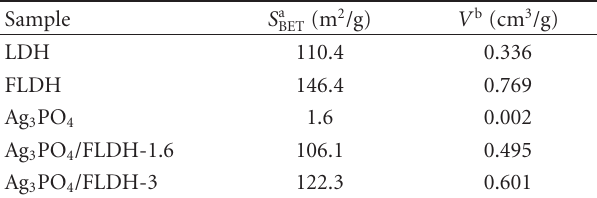
Table 1: Corresponding specific surface area and pore volume for the